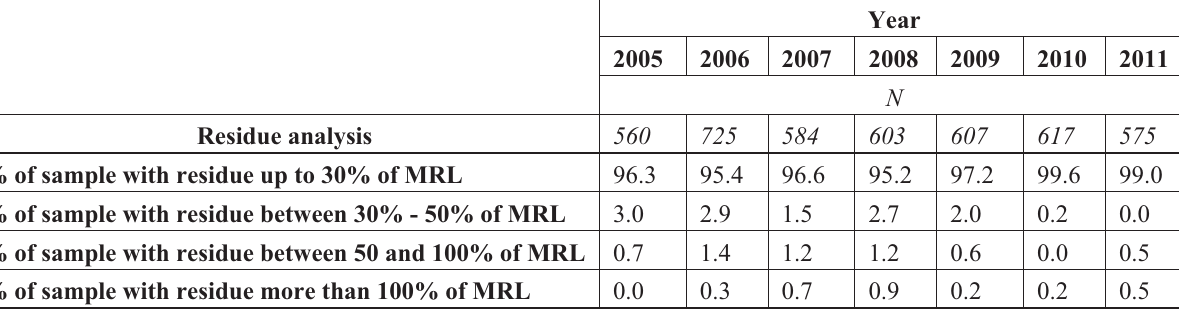
Table 1 Percentage of samples with insecticide/acaricide residues and percentage distribution of samples with respect of pesticide maximum residue levels (n: number of samples analyzed over seven